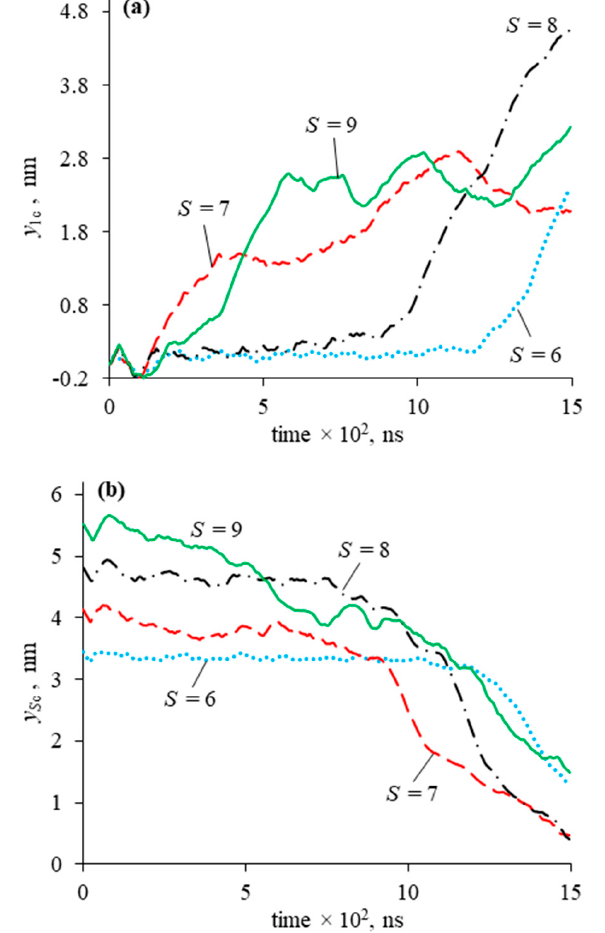
Figure 6. Time dependence of the y -coordinates of the centers of mass of the first ( a ) and last ( b ) nanotori at S = 6,…,9.